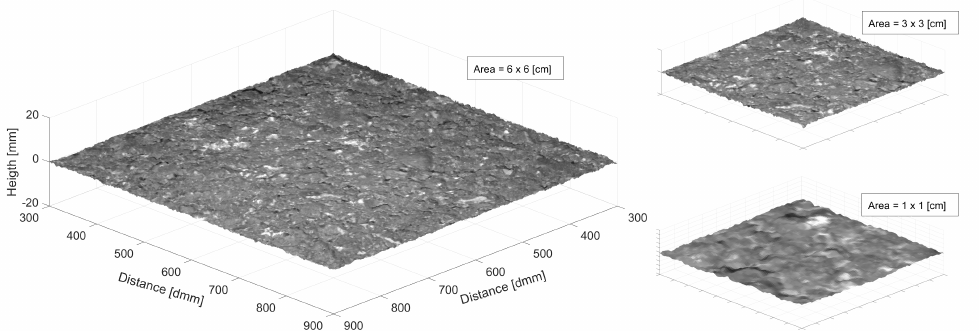
Figure 18. Three–dimensional reconstruction at different scales. Left: 6 × 6 cm. Top Right: 3 × 3 cm. Bottom Right: 1 × 1